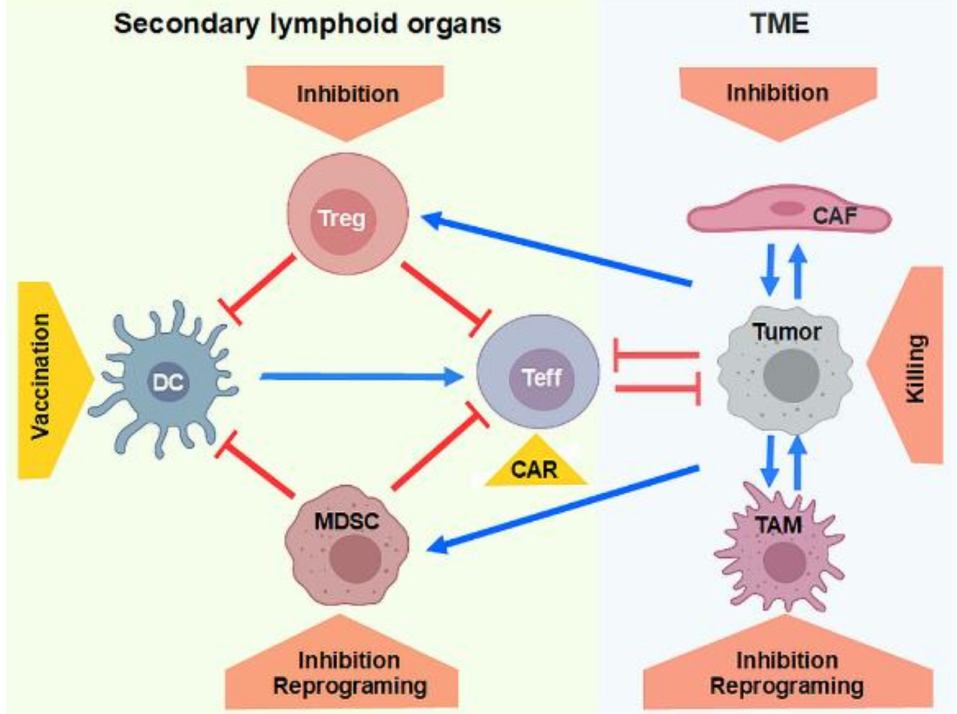
Figure 1. Nucleic acid-based strategies for tumor therapy. Vaccination of dendritic cells (DC) aims to induce tumor-specific e ff ector T cells (Te ff ), which in turn kill tumor cells. Regulatory immune cells, regulatory T cells (Treg) and myeloid-derived suppressor cells (MDSC), are induced by the tumor and other cells of the tumor microenvironment (TEM) and inhibit both DC and Te ff . The expansion and suppressive activity of Treg / MDSC can be inhibited by RNA interference (RNAi) and MDSC may be reprogramed to yield antigen presenting cells by applying nucleic acid-based stimuli. Further, T cells can be transfected / transduced with chimeric antigen receptors (CAR) to gain tumor specificity. Te ff are inhibited by factors within the TME. Tumor-specific delivery of nucleic acids (gene-coding or conferring RNAi) is aimed to induce apoptosis in tumor cells, and to inhibit or reprogram accessory cells within the TME, tumor-associated macrophages (TAM), and cancer-associated fibroblasts